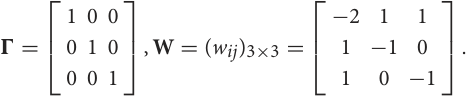
y ( t ) x ( t ). (B) Instants for anti-synchronization ε ( t ) = −